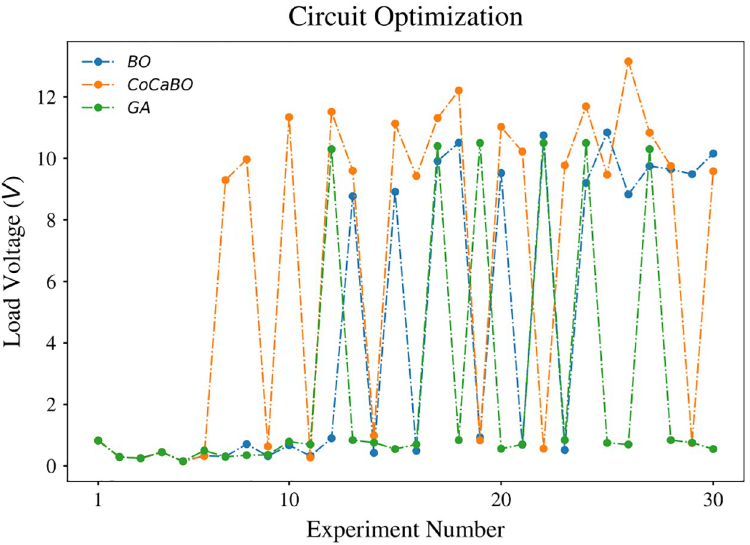
Fig 8. Result of circuit optimization with two obstacles. Similar performance is achieved by CoCaBO that outperforms both BO and GA (21.3% and 25.7% higher respectively).